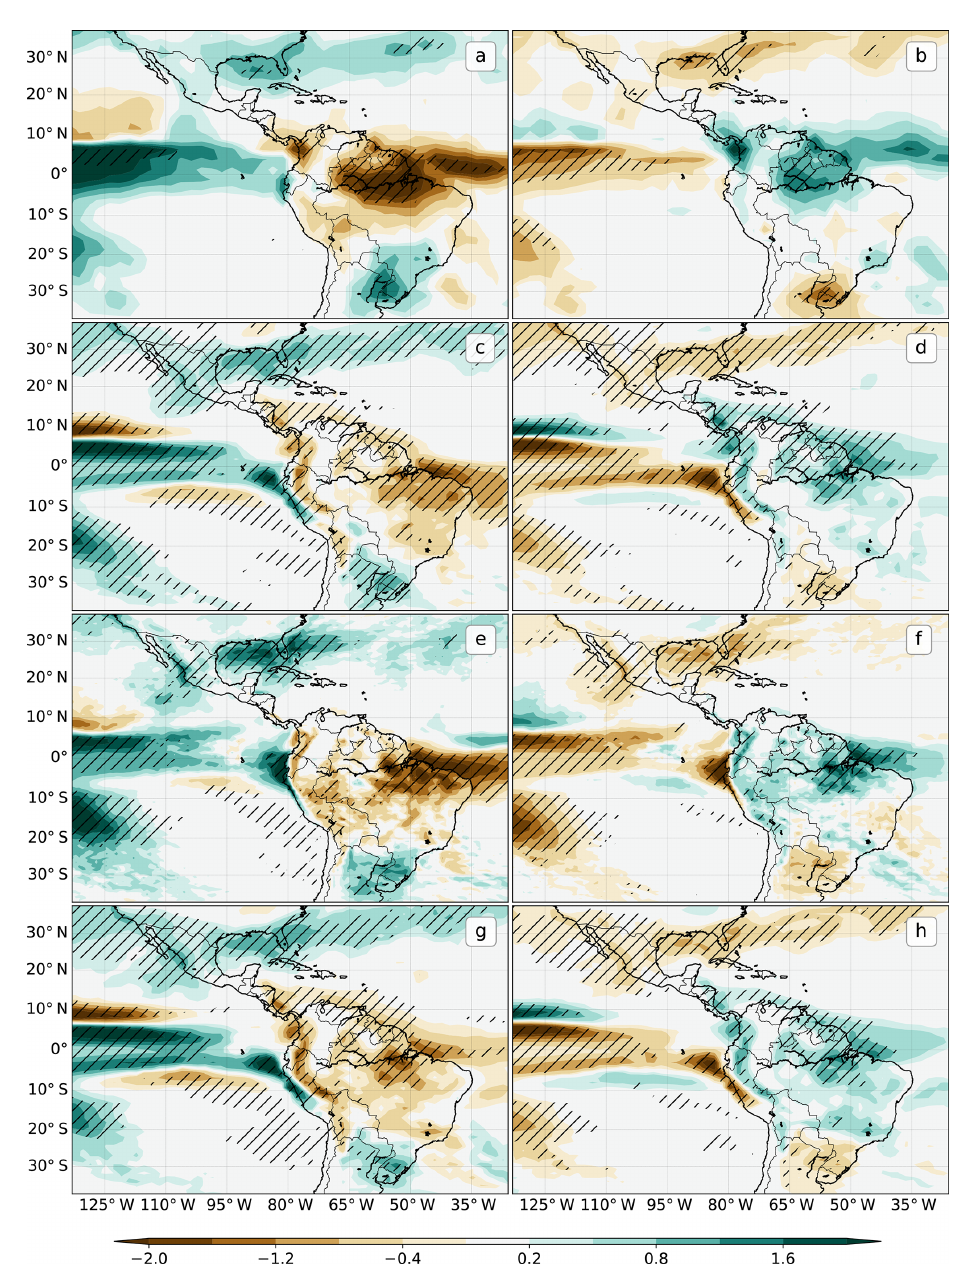
Figure 11. As in Fig. 10 but for the rainfall response (mmd − 1 ) using GPCP as the observational dataset.